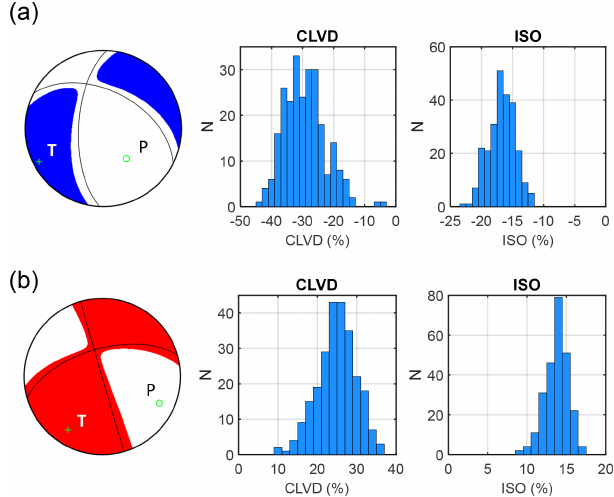
Figure 6. Examples of focal mechanisms and histograms of the CLVD and ISO errors. (a) Earthquake on 1 September 2011 at 12:54:05.7UTC with M L = 0 . 6 and (b) earthquake on 11 May 2018 at 06:26:09.0UTC with M L = 2 .